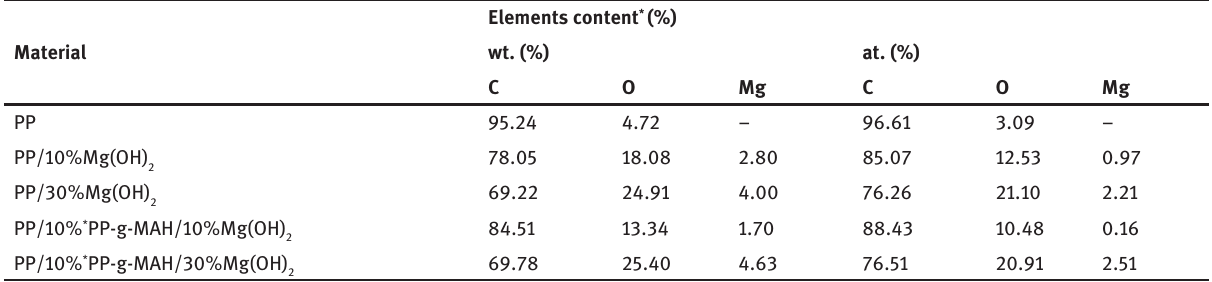
Table 1: Chemical composition of pure PP and tested composites.